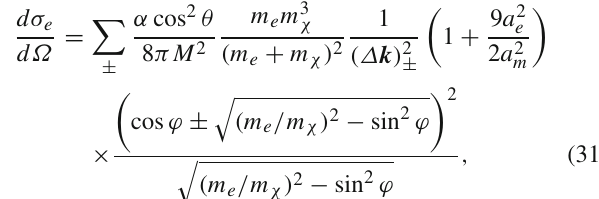
mass if we assume a ratio ( a e / a m ) 2 . Integration of d σ e / d